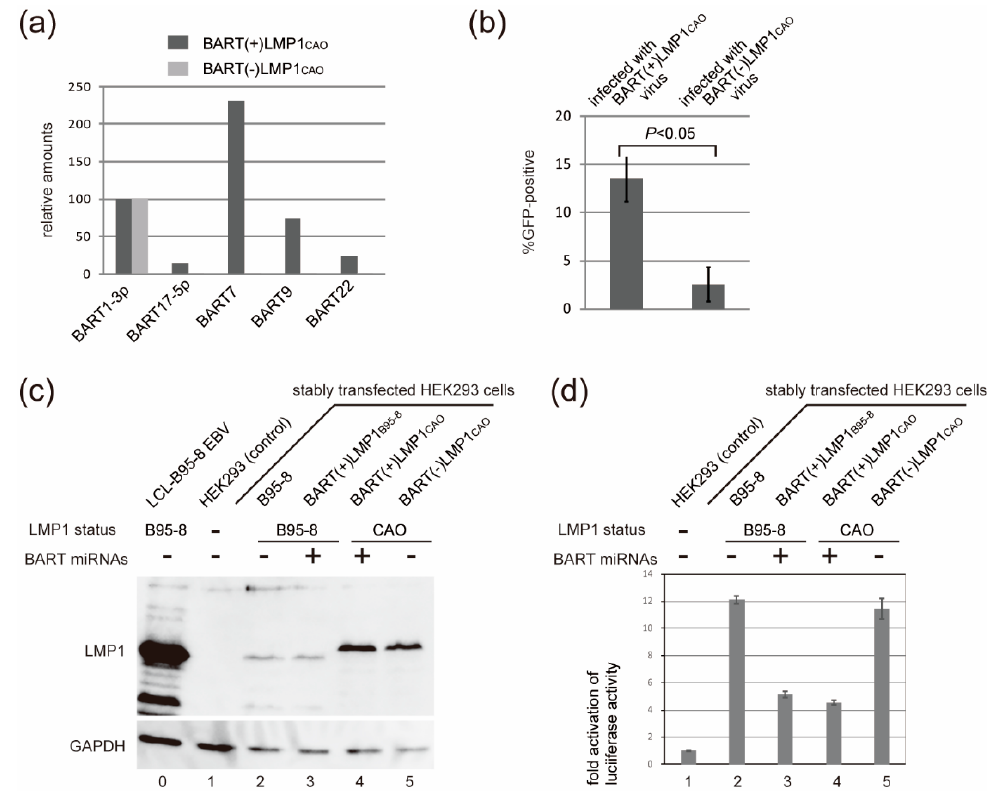
Figure 4. Expression of latent viral proteins by stably transfected HEK293 cells or LCLs. Expression of EBV nuclear antigen 1 (EBNA1) and LMP1 was examined by Western blot analysis. Glyceraldehyde-3-phosphate dehydrogenase (GAPDH) was used as a control.